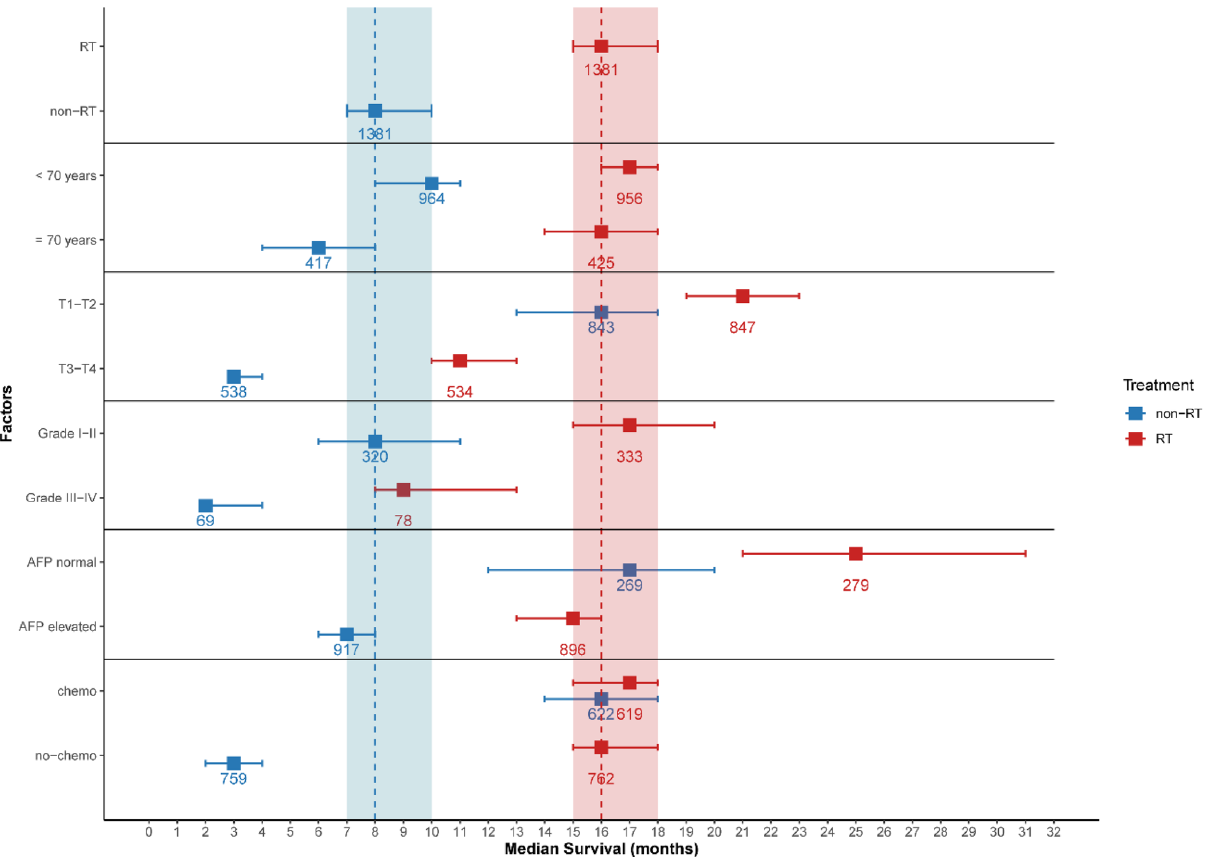
Figure 4. Median overall survival (months) ± 95% confidence intervals for patients in RT and non-RT. RT radiotherapy, AFP